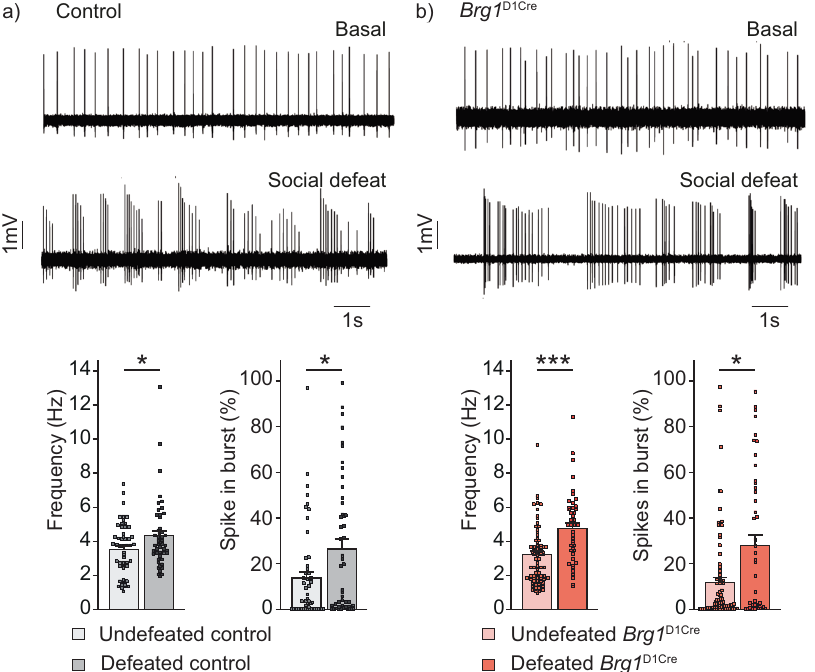
Fig. 4 Consequences of repeated social defeat on ventral tegmental area dopamine neurons spontaneous activity in control and Brg1 D1Cre mice. a Representative traces of dopamine neurons activity in undefeated (upper trace) and defeated (lower trace) control mice. Firing frequency (left chart) and percentage of spike in burst (right chart) in undefeated ( n = 51 neurons) and defeated ( n = 51 neurons) control mice. Two-sided T-test (for frequency) and Mann-Whitney test (spike in burst) * p = 0.0244 and p = 0.0407 respectively. b Representative traces of dopamine neurons activity in undefeated (upper trace) and defeated (lower trace) Brg1 D1Cre mice. Firing frequency (left chart) and percentage of spike in burst (right chart) in undefeated ( n = 81 neurons) and defeated ( n = 45 neurons) Brg1 D1Cre mice. Two-sided T-test (for frequency) and Mann-Whitney test (spike in burst) *** p < 0.0001, * p = 0.0222. Data are represented as mean ± s.e.m. Data are provided in a Source Data fi